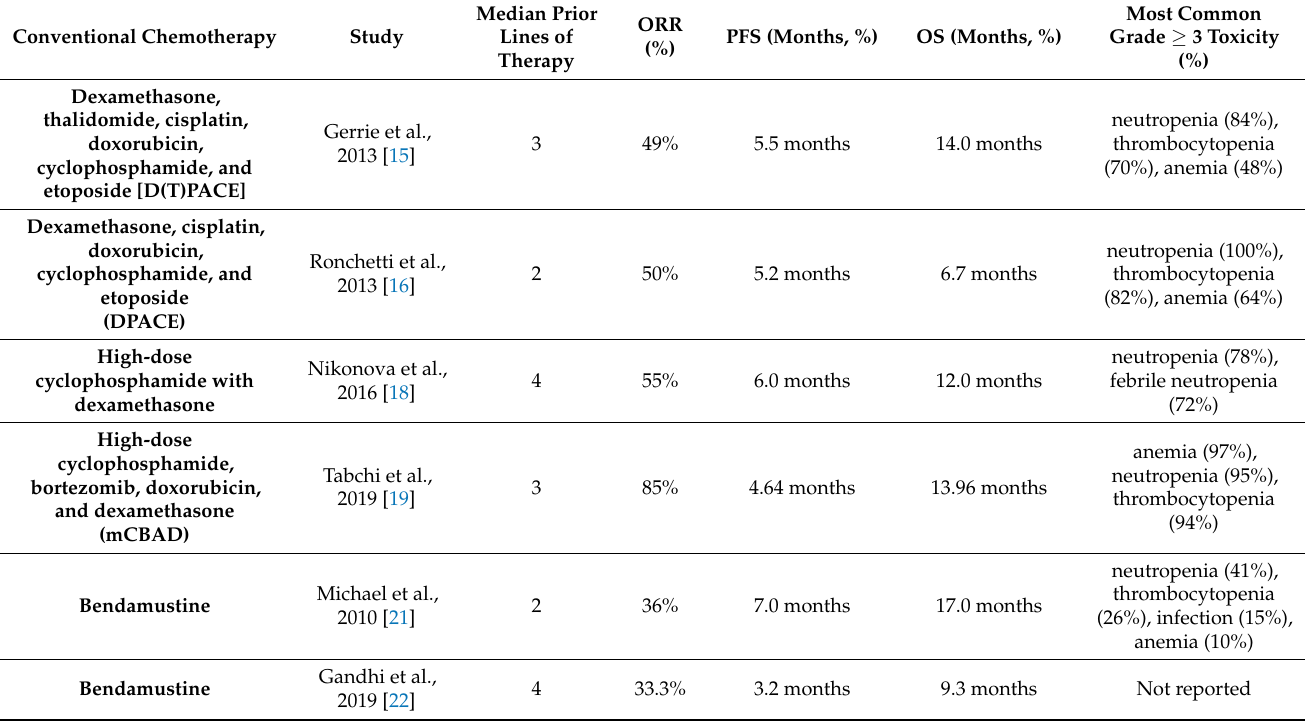
Table 1. Conventional chemotherapy regimen clinical trial results in relapsed or refractory multiple